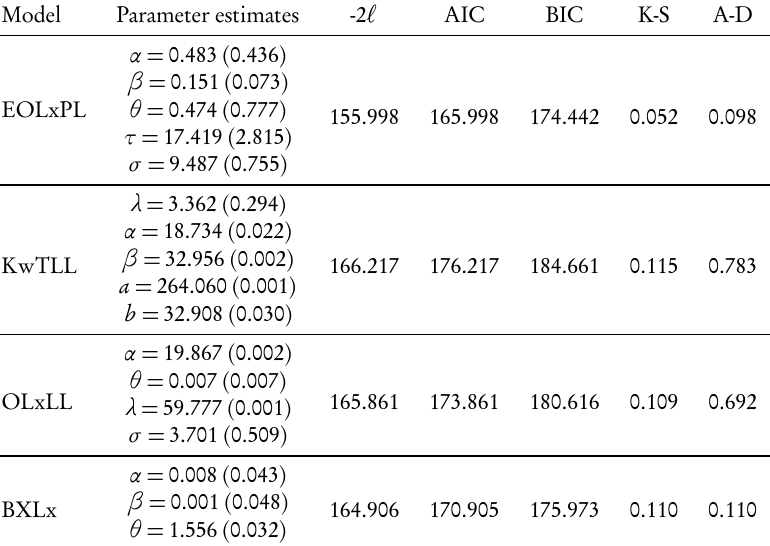
Model comparison for turbochargers failure ( 10 3